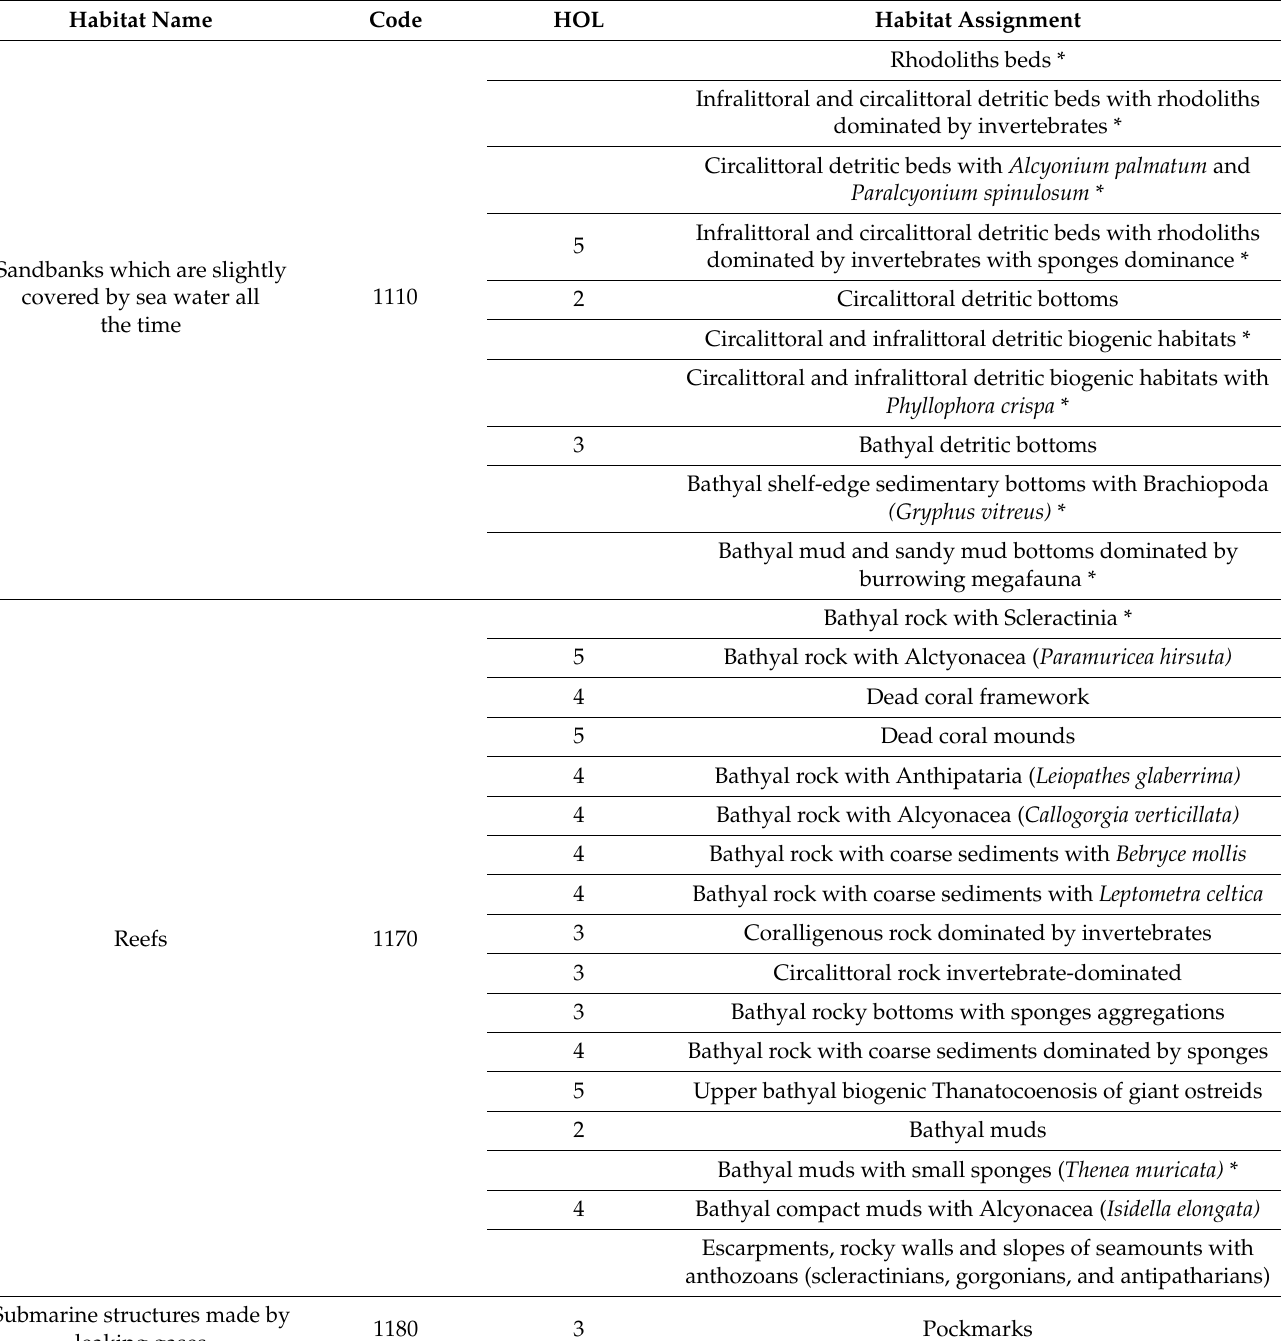
Table 5. Categories of benthic habitats identified from ROTV and ROV video transects in th Ses Olives, Ausias March, and Emile Baudot seamounts of the Mallorca Channel (Balearic Islands, western Mediterranean) during the INTEMARES project. Their name, code, and hierarchical organization level (HOL; ranging from 1 for the more generalist and least detailed one to 5 for the level with the highest detail and knowledge) were assigned according to the Habitats Directive, with some exceptions (*) identified during the previous INDEMARES project